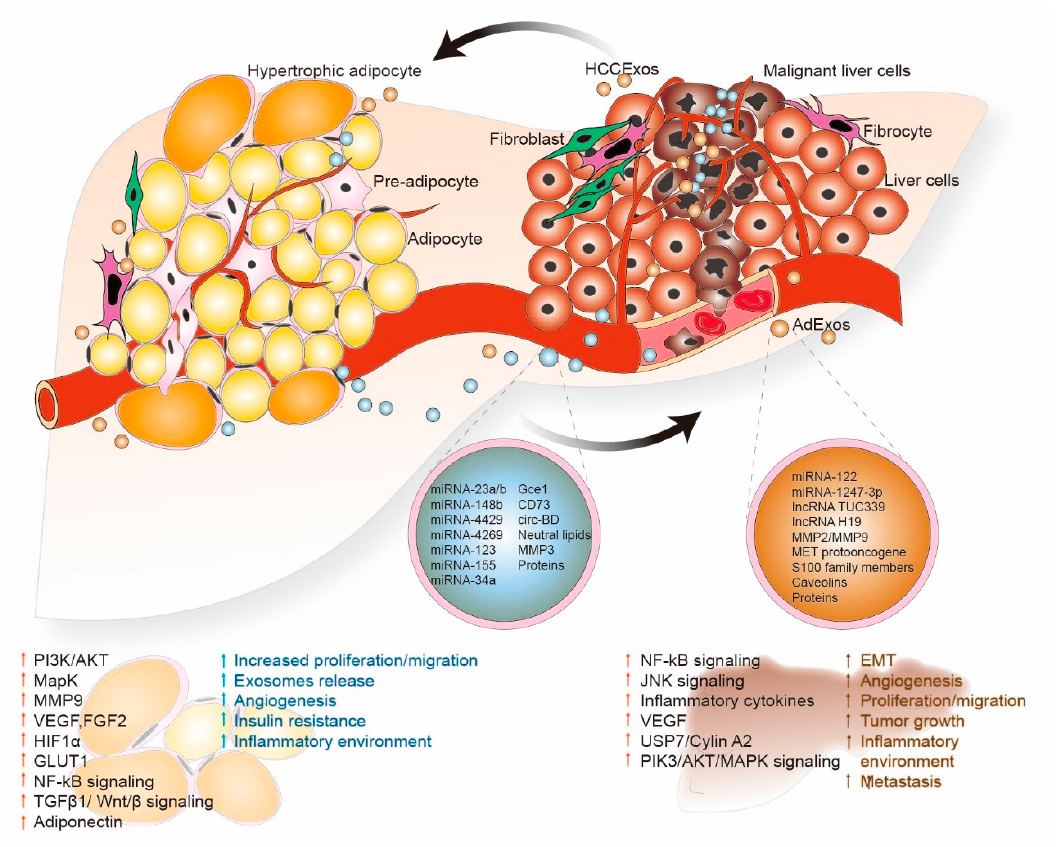
Figure 3. Adipocyte and HCC exosomes crosstalk leading to increased tumor progression. Exosomes released by both adipocytes (AdExos) and HCC (HCCExos) have unique intracellular components, including a wide variety of mRNAs, microRNAs, lncRNAs, circRNAs, lipids, metabolites and proteins. These intracellular components are utilized as autocrine or paracrine communicators to induce pathways that result in increased cell proliferation, angiogenesis, invasion, and other hallmarks of malignancy. HCCExos not only modulate tumorigenesis, but also promote angiogenesis.